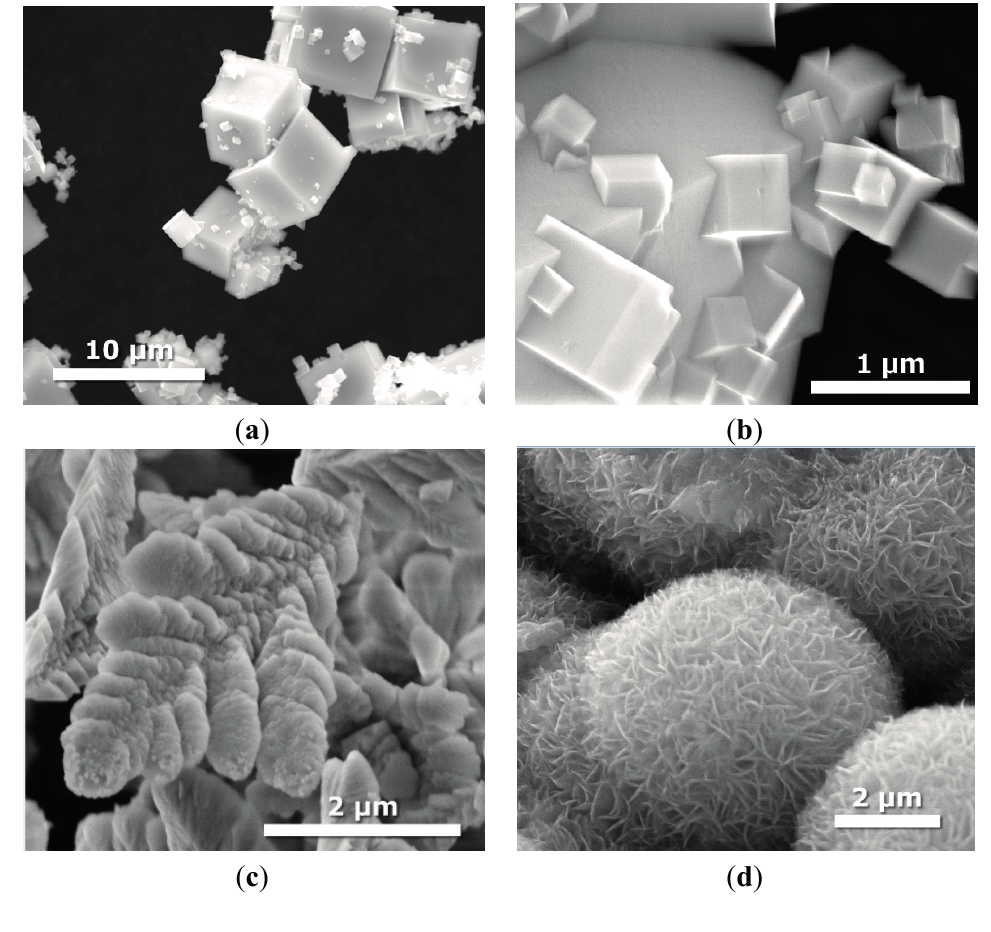
Figure 2. SEM images of single semiconductors obtained by hydrothermal method: ( a , b ) KTaO 3 ; ( c ) CdS; ( d ) MoS 2